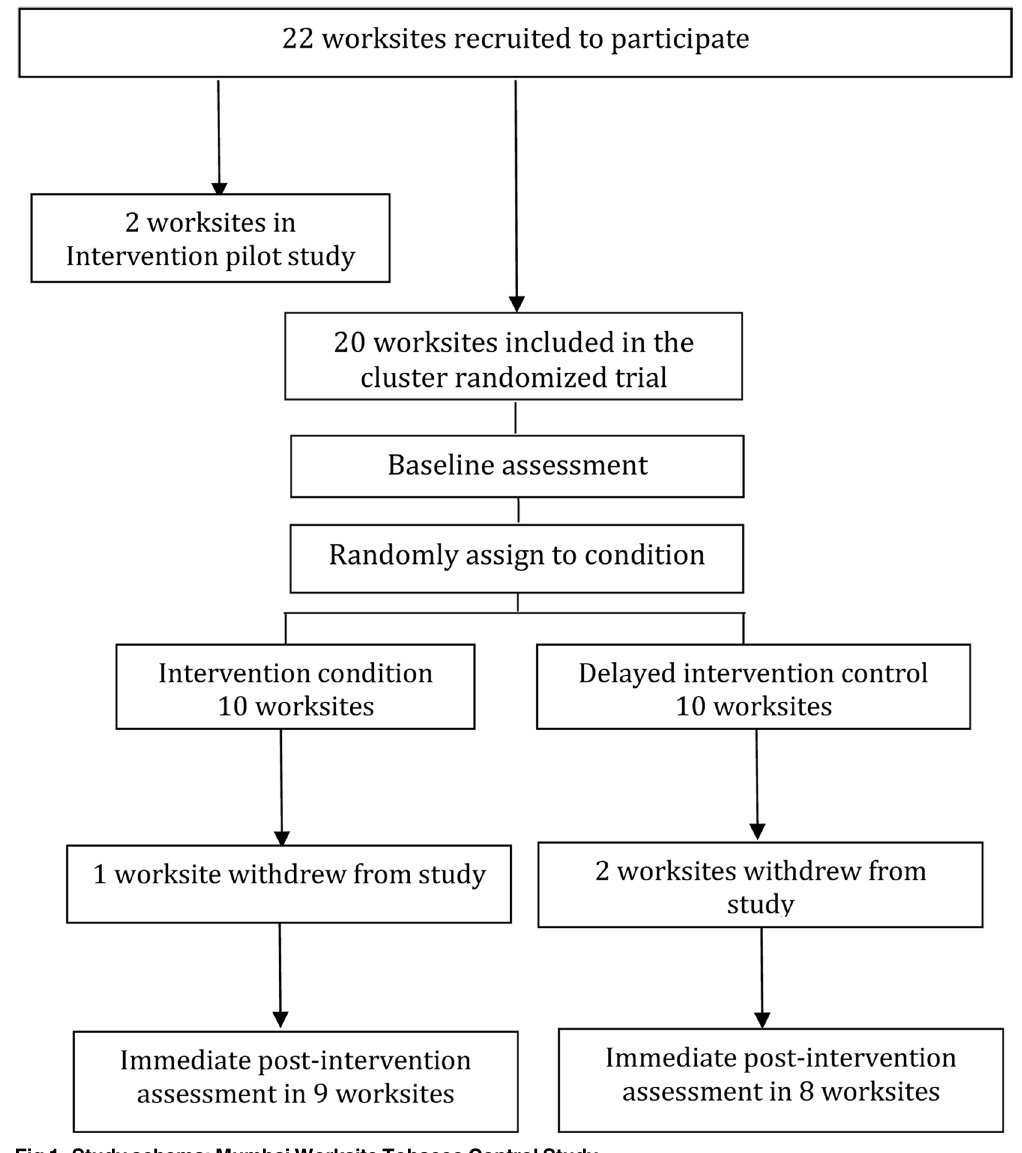
Fig 1. Study schema: Mumbai Worksite Tobacco Control